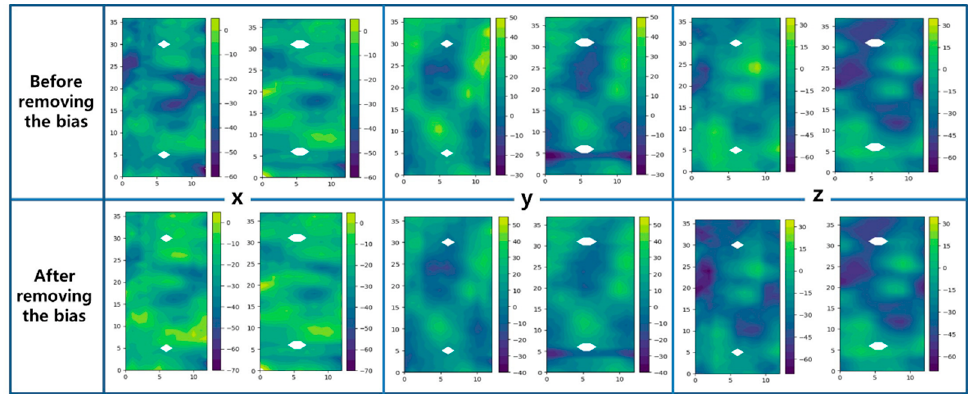
Figure 8. Comparison of the magnetic field map based on the embedded hardware (left side inside the box) before and after removing the bias and the magnetic field map collected by the smartphone (right side inside the box).